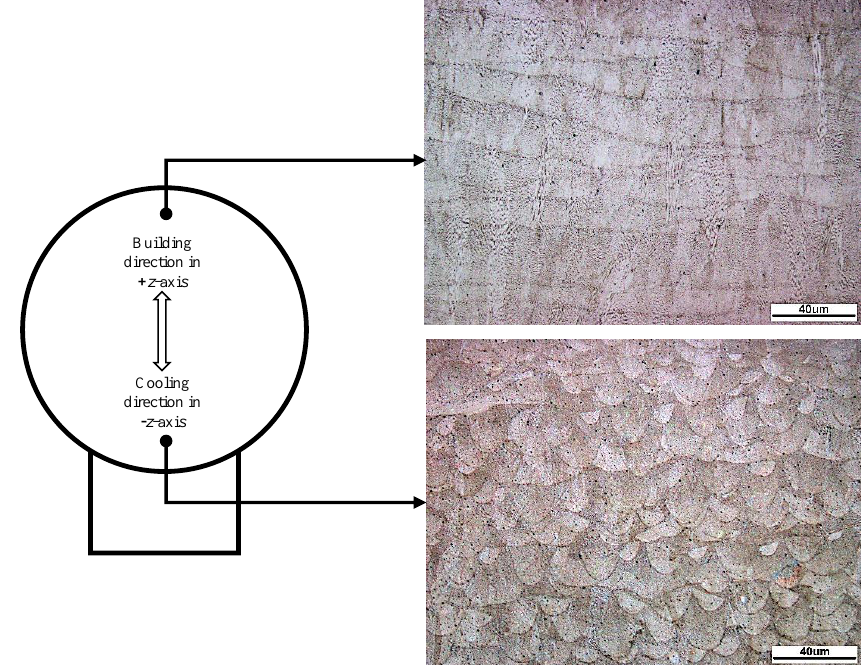
Figure 7. Melt pool morphology with reference to the SLM-printed cylinder, for both top and near substrate deposited layers.